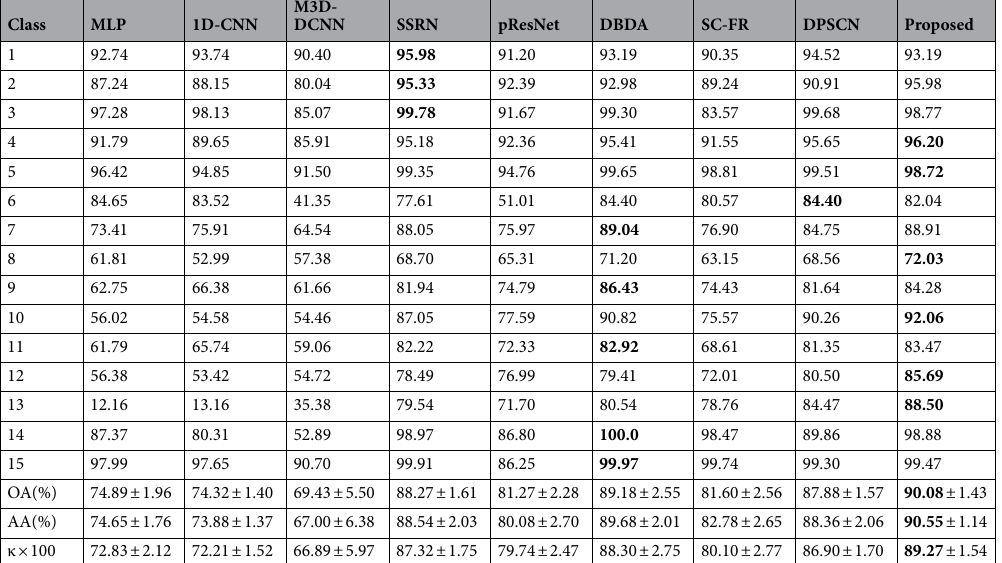
Table 8. Classification results of 1% samples of HU dataset. Significant values are in